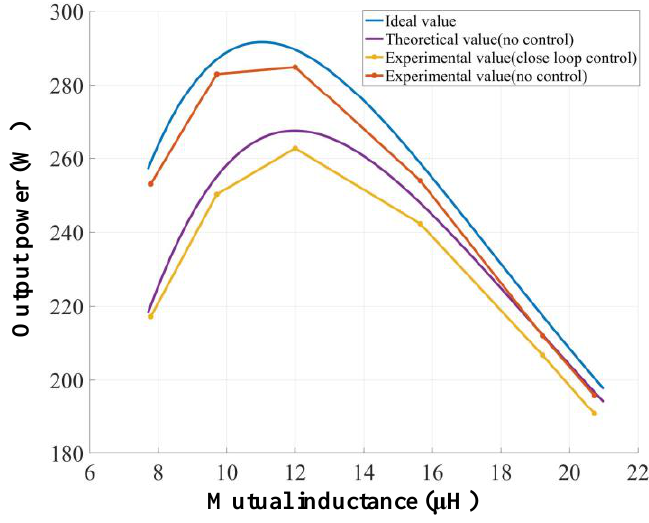
Figure 17. Output powers under different conditions.